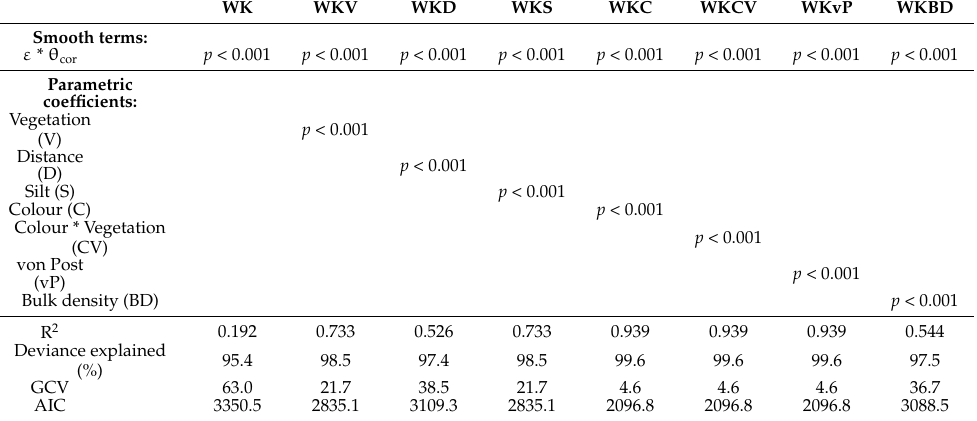
Table 3. Generalised additive models explored to predict the content of organic carbon at Vejrumbro based on in situ measurements of dielectric permittivity ( ε = K) and the corrected volumetric water content ( θ cor = W) as interacting smooth terms and different categorical (parametric) variables. Bold letters denote components in model names. Full model performances are provided in the Figure